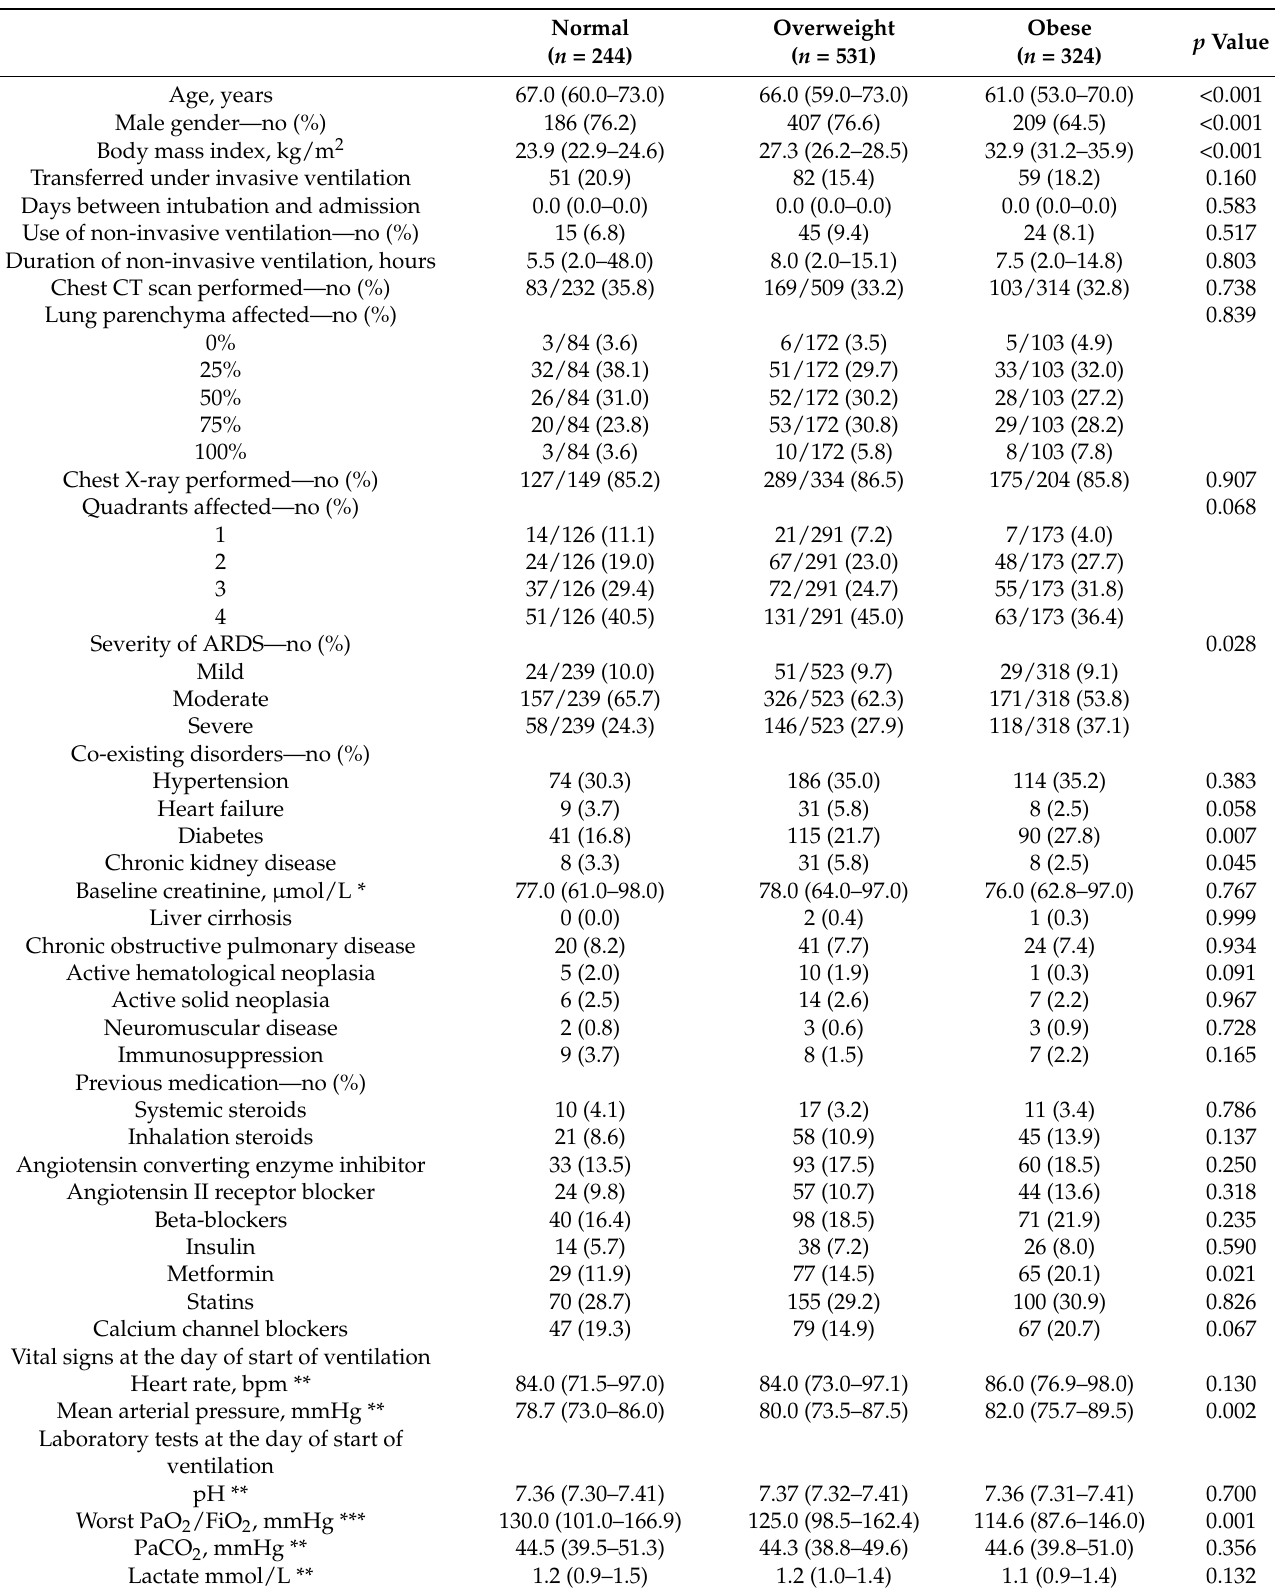
Table 1. Baseline characteristics, vital signs, laboratory test results, and organ support on the first day of ventilation according to BMI